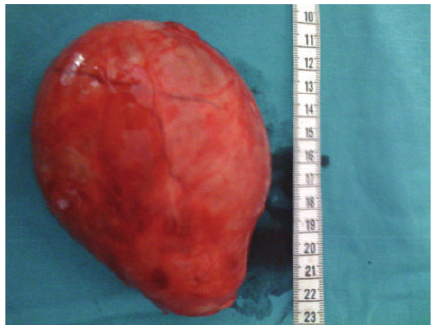
Figure 6: Resected encapsulated mass.